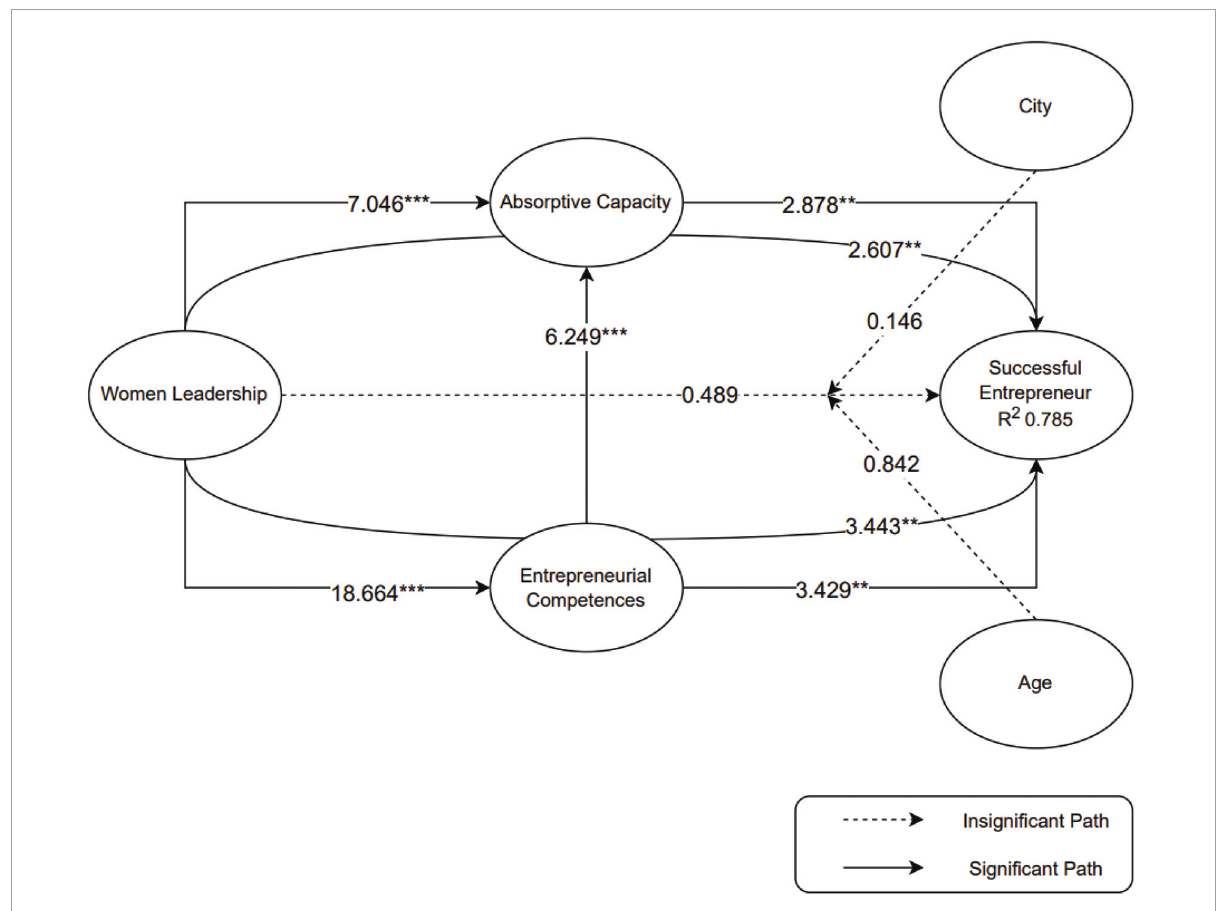
FIGURE4 Path significance (*** p < 0.001, ** p < 0.01, * p <